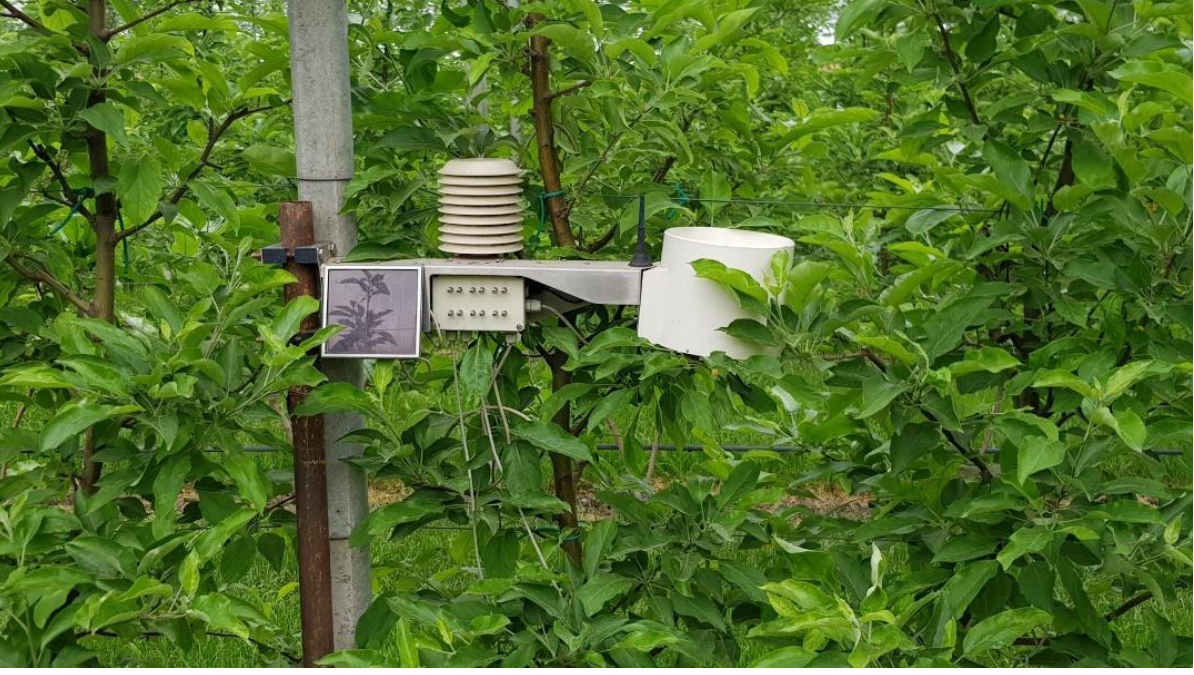
Figure 2. The AWS located inside the canopy air space in the fruit tree row.